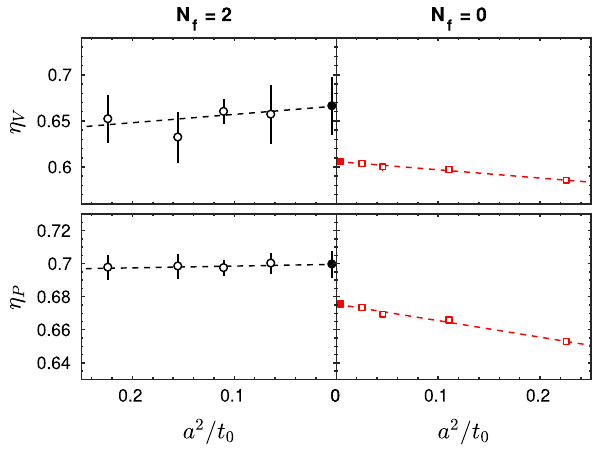
Fig. 6 Continuum limits of the mass scaling functions η P and η V in both the N f = 2 (left) and N f = 0 (right) theories